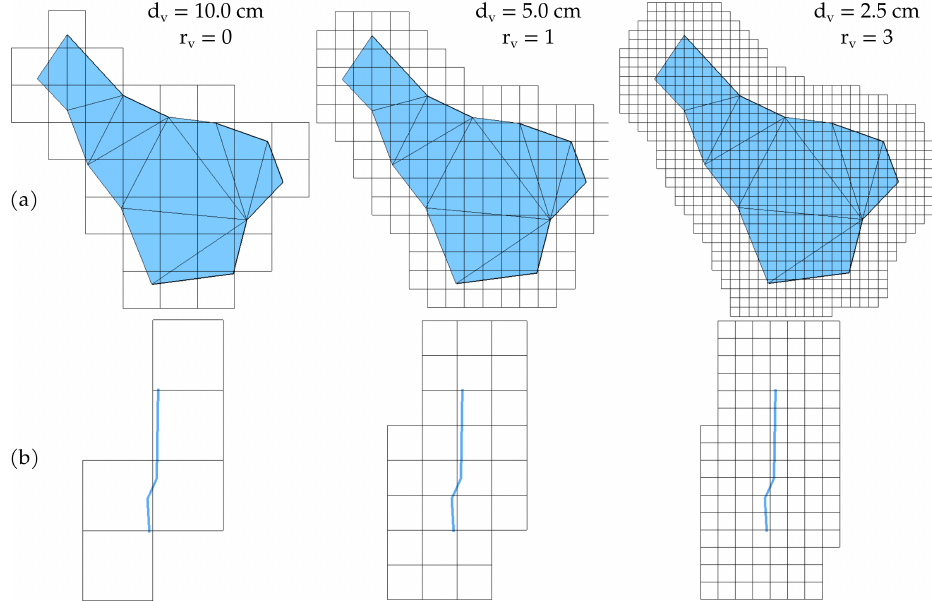
Figure 14. Different combinations of d v and r v (all lead to u max = 17.3cm) for annotated ( a ) missing plaster surface and ( b ) crack